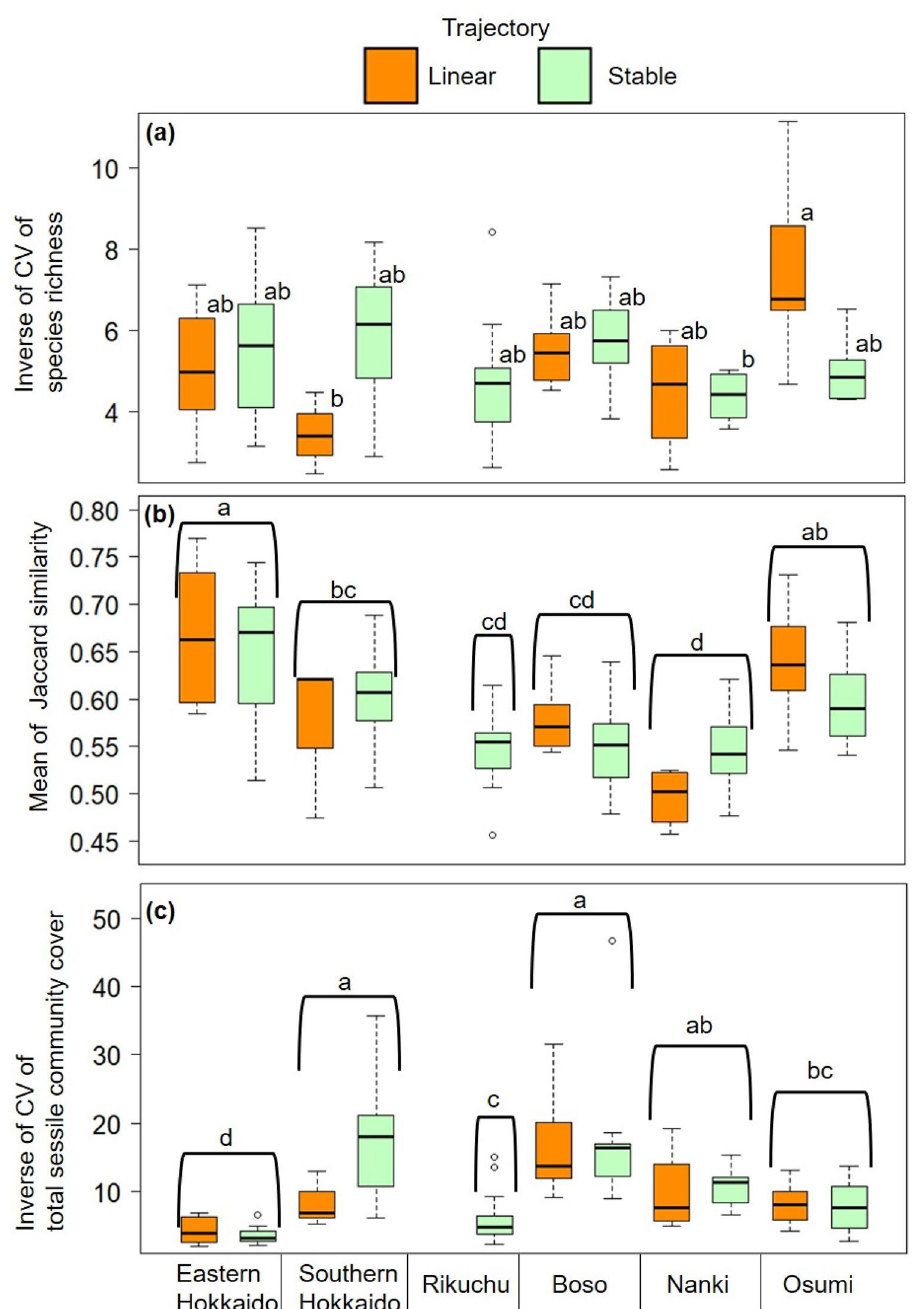
Figure 3. Box plots of the temporal invariability of ( a ) species richness, ( b ) species composition, and ( c ) community abundance. Box plots show the median, minimum, maximum, and first and third quartiles. Different letters indicate statistical differences in post hoc Bonferroni pairwise comparisons at P <